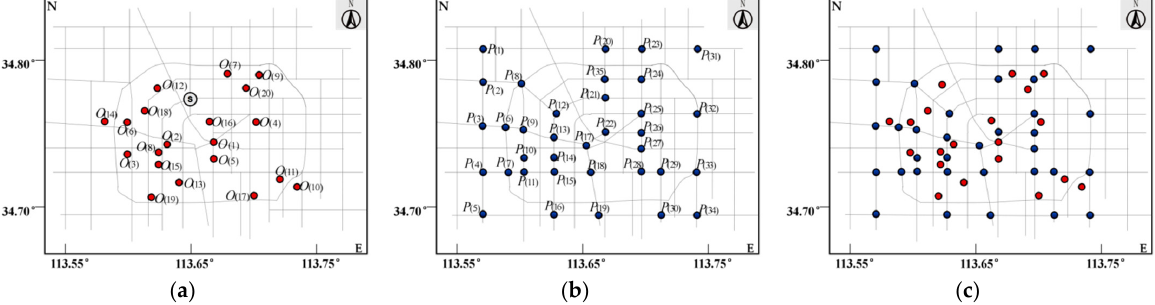
Figure 6b is the distribution of P ( and P ( . v )